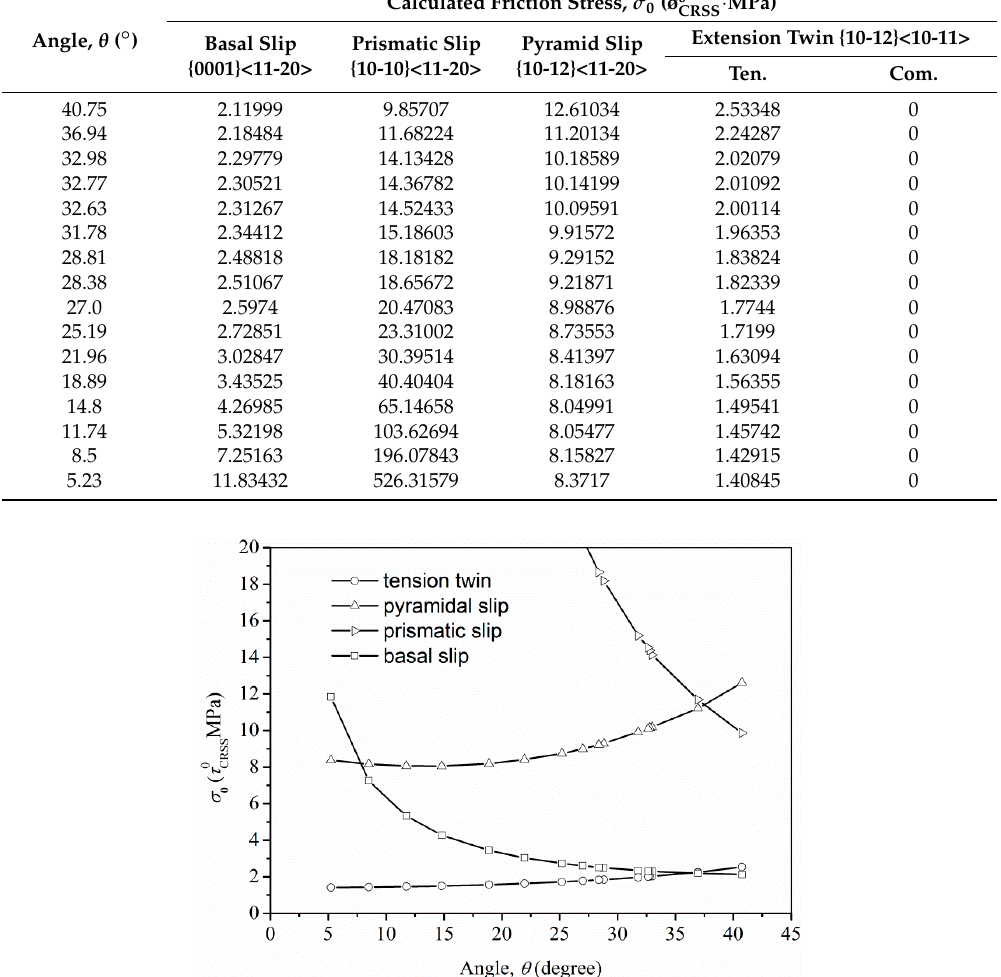
Figure 11. Calculated friction stress, σ 0 , for different deformation modes as a function of the angle, θ , between the c-axes of the grains and the ED based on Table 4.